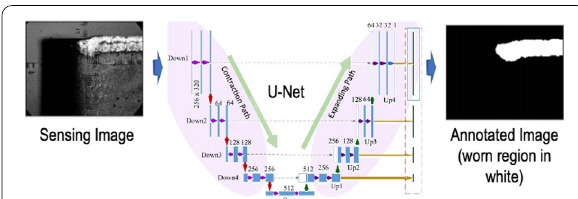
Figure 15 U-Net for tool wear image annotation, adapted from Ref.